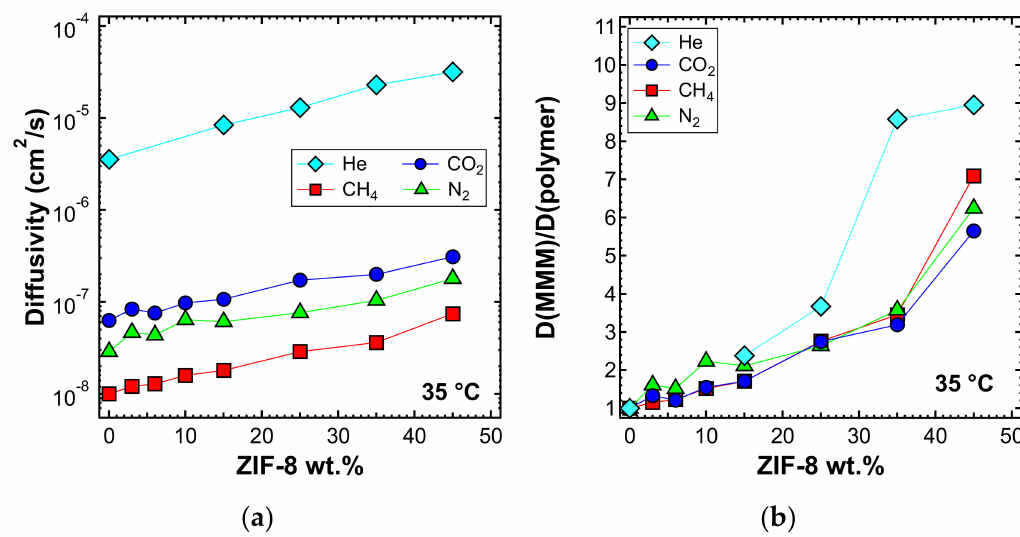
Figure 16. ( a ) Di ff usivity and ( b ) relative di ff usivity increase of various gases at 35 ◦ C in ZIF-8 / PPO mixed-matrix membranes (MMMs), estimated with the time-lag method.